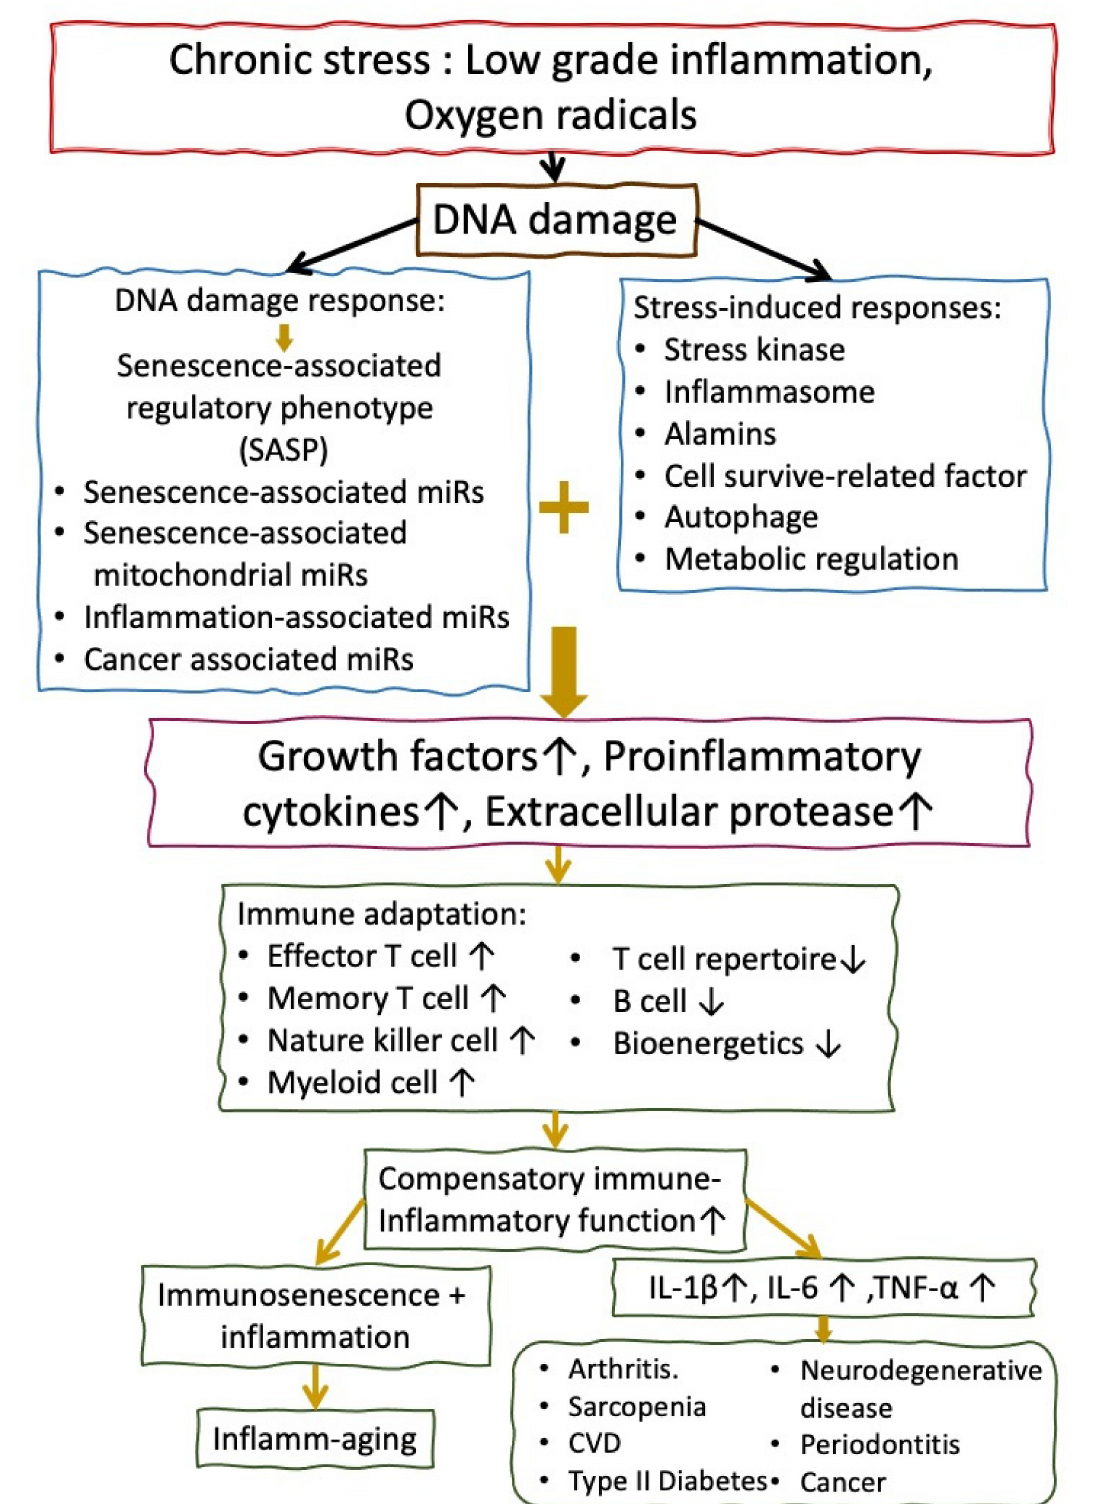
Figure 4. The chronic stresses induced by low-grade inflammation and increased oxygen radicals as upstream etiological factors in mediating abnormal DNA damage/DNA damage responses, immune adaptation manifested by compensatory immune-inflammatory function, and inflamm-aging in patients with SSc. Accelerated inflamm-aging in SSc may in- crease inflammation-associated diseases such as arthritis, sacropenia, cardiovascular diseases, neurodegenerative diseases, periodontitis, type II diabetes, and cancers via immune